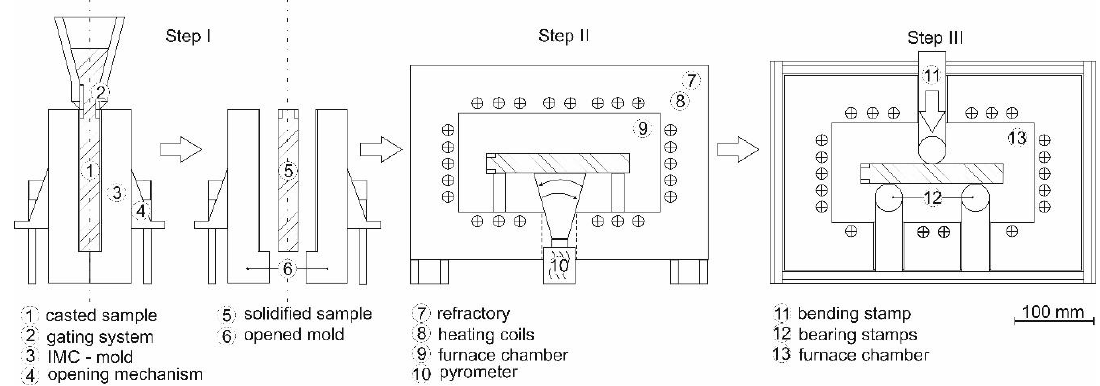
Figure 1. Principle of the “In-situ Materials Characterization by Bending” (IMC-B) test. Step I: melting, casting, solidification, and stripping. Step II: controlled cooling. Step III: isothermal 3-point bending test.